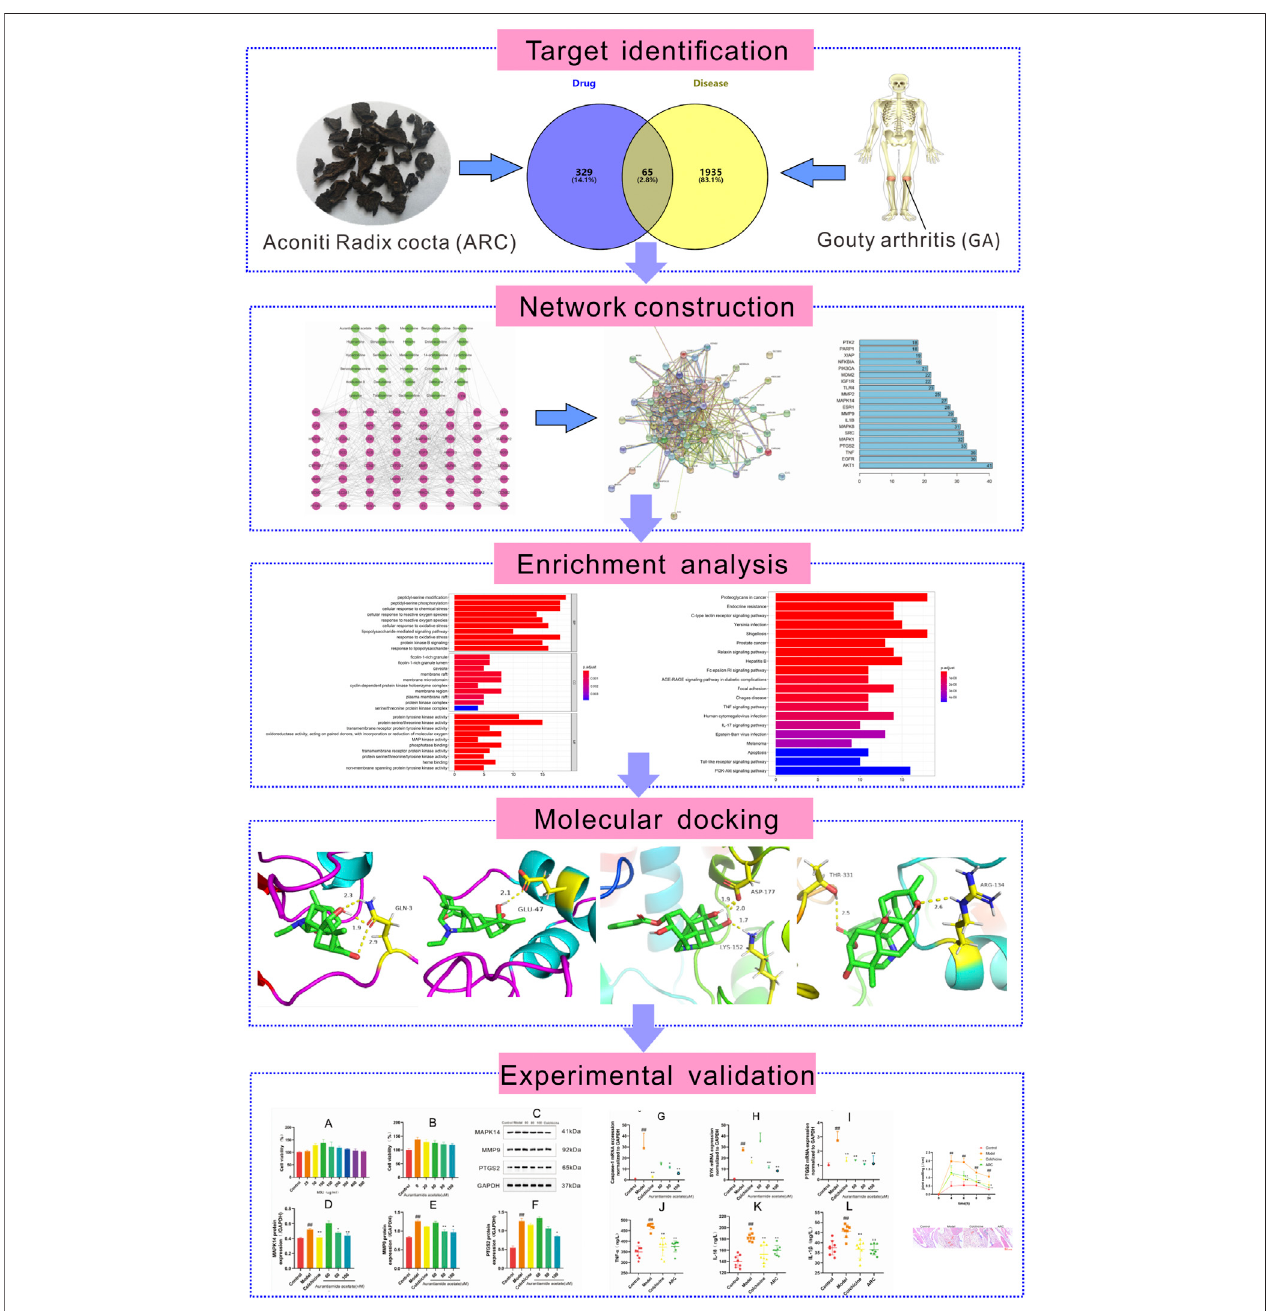
FIGURE 1 | Systems pharmacology-based strategy to study the molecular mechanism of ARC in treatment of gouty arthritis.